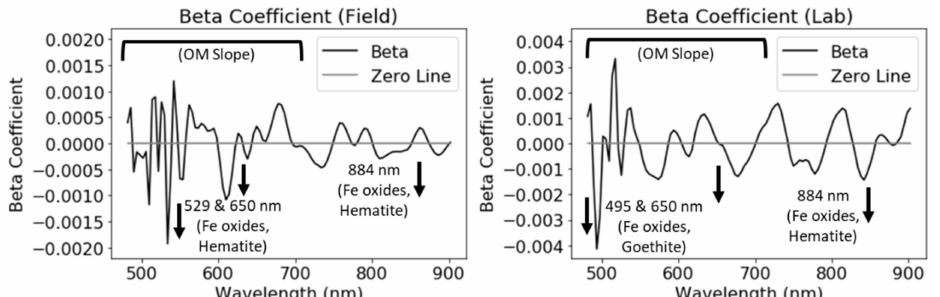
Figure 10. Beta coefficients for the prediction of WIR using the samples of the sandy group with the resampled data (to the Cubert spectral